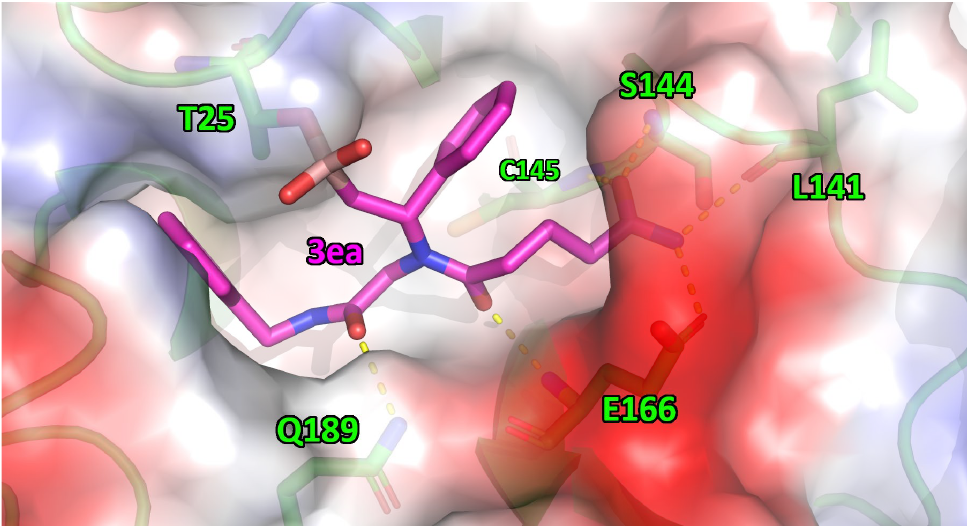
Figure 3. Supposed binding mode of 3ea (magenta sticks) in complex with Mpro CoV-2 . The enzyme surface is represented as a “solvent accessible surface”, in which the partial charges of the residue atoms are colored in blue or in red, accordingly with their positive or negative charge. The hydrogen bonds are represented as dashed yellow lines. Residues are numbered as was found in the X-ray structure.